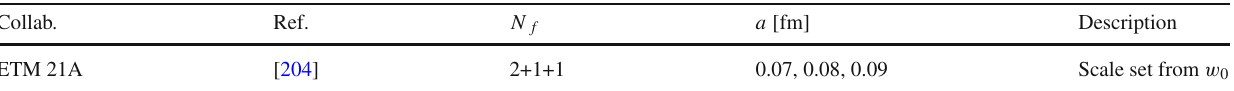
Table 79 Continuum extrapolations/estimation of lattice artifacts in determinations of m ud , m s and, in some cases m u and m d , with N f = 2 + 1 + 1 quark flavours Collab. Ref. N f a [fm]